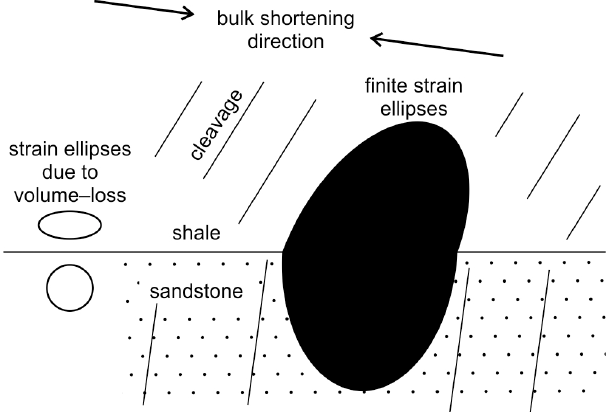
Figure 1. Graphic representation of Sorby’s ideas (Sorby, 1853) on the superposition of the deformation caused by volume loss (only possible normal to bedding) on the deformation due to general shortening of the rock and how this causes different but compatible finite strain ellipses in each lithology. Cleavage parallels the finite strain ellipses, being thus refracted. Figure based on Ramsay and Huber (1987, Fig.